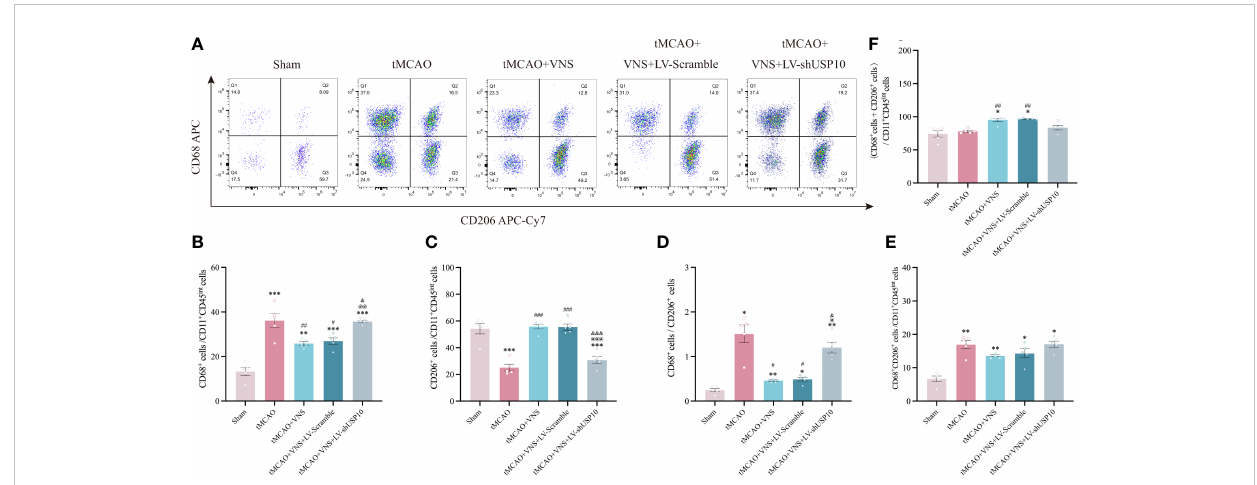
FIGURE 6 Flow cytometry shows USP10 silencing reversed the effect of VNS on microglial activation. (A) Quanti fi cation of CD68 + and CD206 + cells after gating strategy sorting of CD11b + CD45 int microglia. (B) The ratio of CD68 + cells to CD11b + CD45 int cells is illustrated as a histogram. (C) The ratio of CD206 + cells to CD11b + CD45 int cells is illustrated as a histogram. (D) Quanti fi cation of CD68 + /CD206 + ratio. (E) Quanti fi cation of CD68 + CD206 + cells to CD11b + CD45 int cells ratio. (F) Quanti fi cation of the total reactive microglia by the sum of CD68 + + CD206 + cells to CD11b + CD45 int ratio.